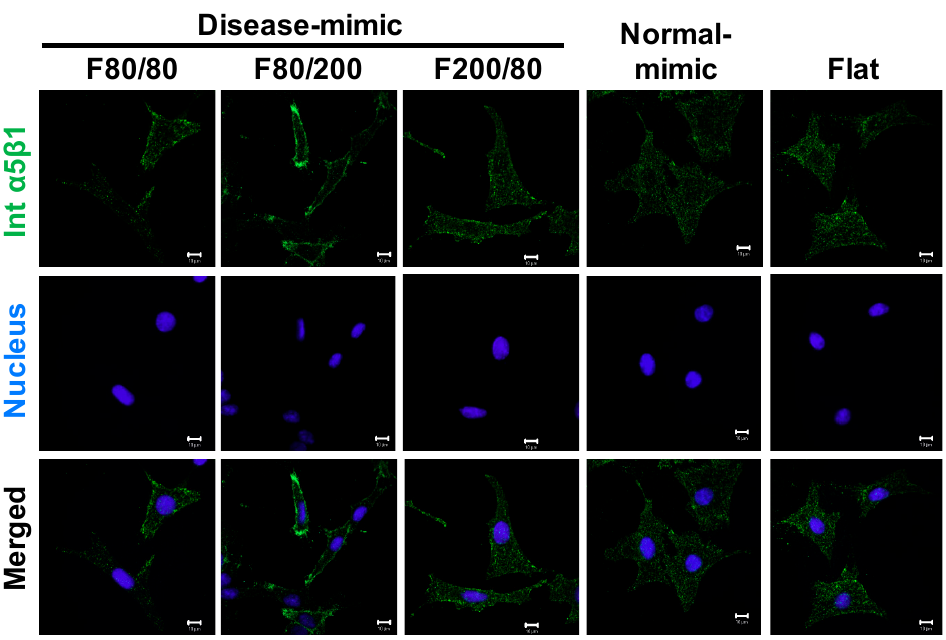
Figure 7. Integrin α 5 β 1 expression in MES13 cells influenced by disease- and normal-mimic nanopatterns. Confocal microscopy images show integrin α 5 β 1 (Int α 5 β 1, green) and nuclei (blue) in cells after culturing on TiO 2 nanopatterns for 24 h. Scale bar = 10 µ m.